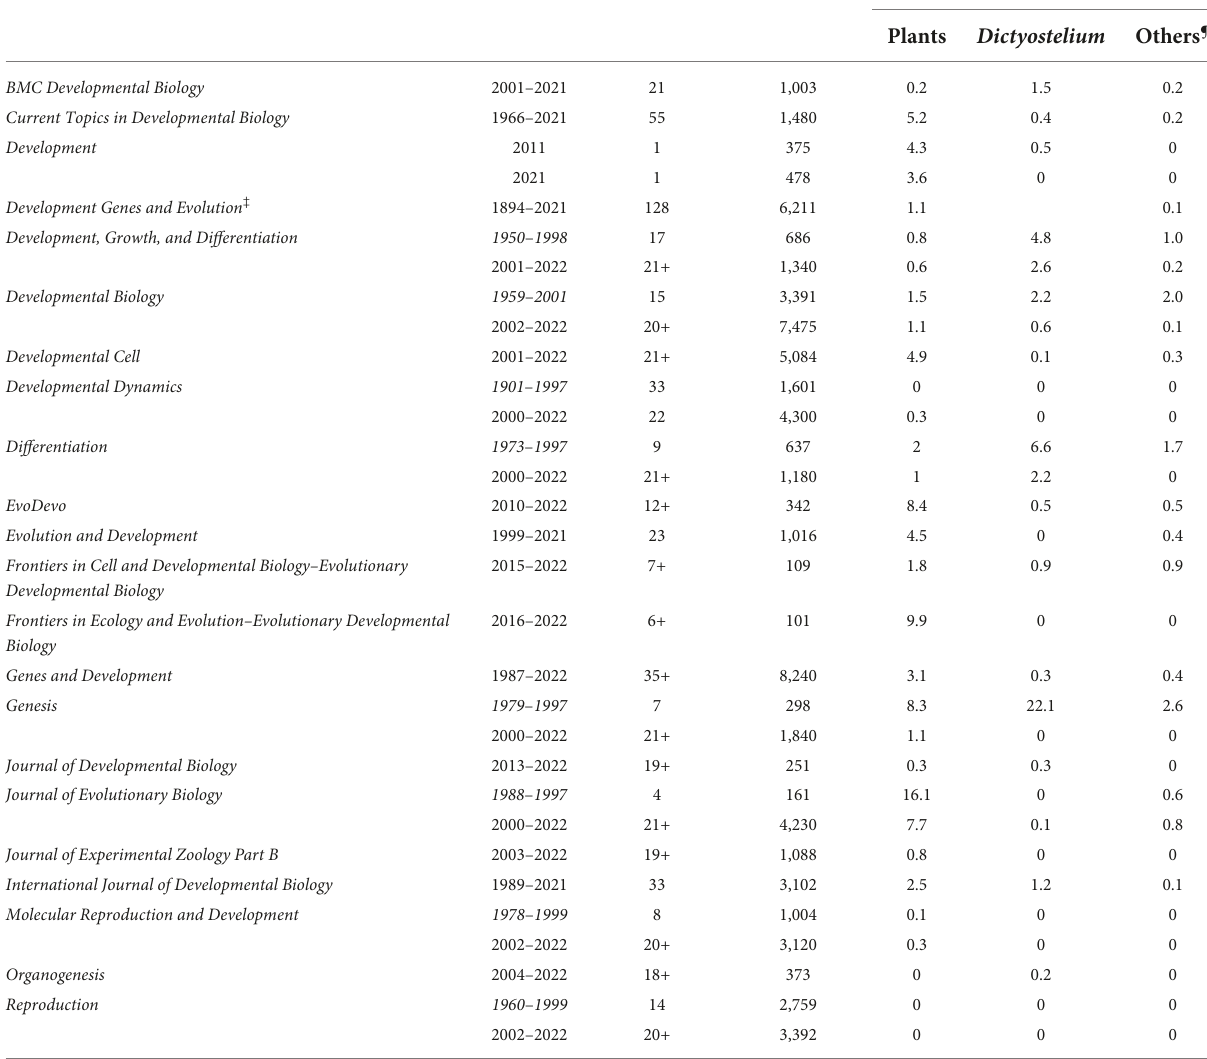
TABLE 1 Quantitative analysis of papers on organisms other than animals (plants, Dictyostelium , others) in the major journals on developmental biology and evolutionary developmental biology, and in the Journal of Evolutionary Biology